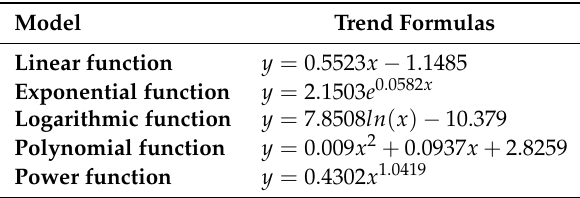
Table 2. Harvest area.